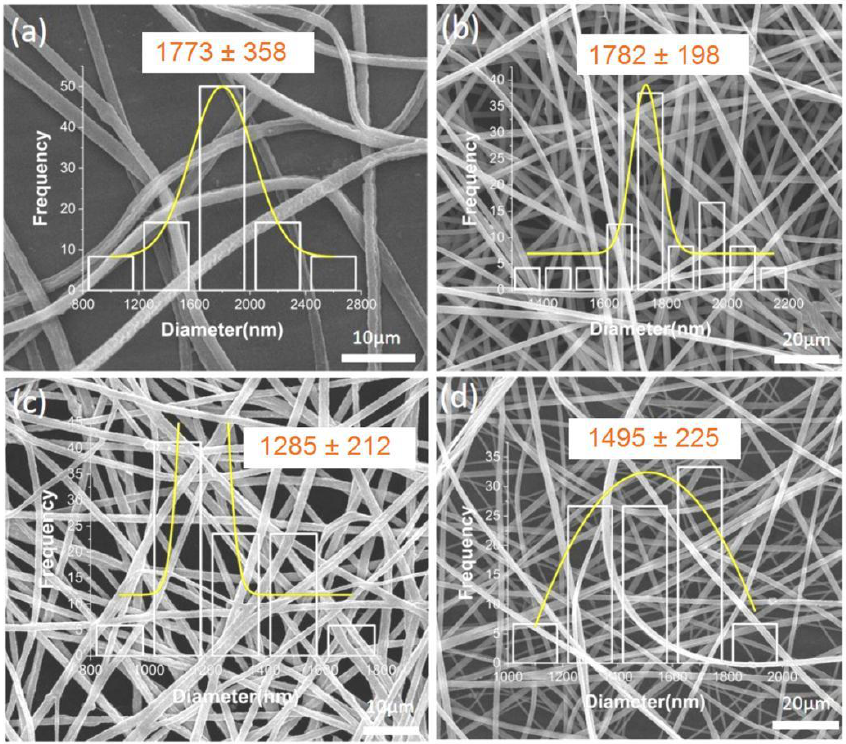
Figure 4. SEM image of coaxial electrospinning fibers loaded with FA: ( a ) F4 fiber loaded with 10% FA in the core layer; ( b ) F5 fiber loaded with 10% FA in the sheath layer; ( c ) F6 fiber loaded with 15% FA in the core; ( d ) F7 fiber loaded with 15% FA in the sheath layer.